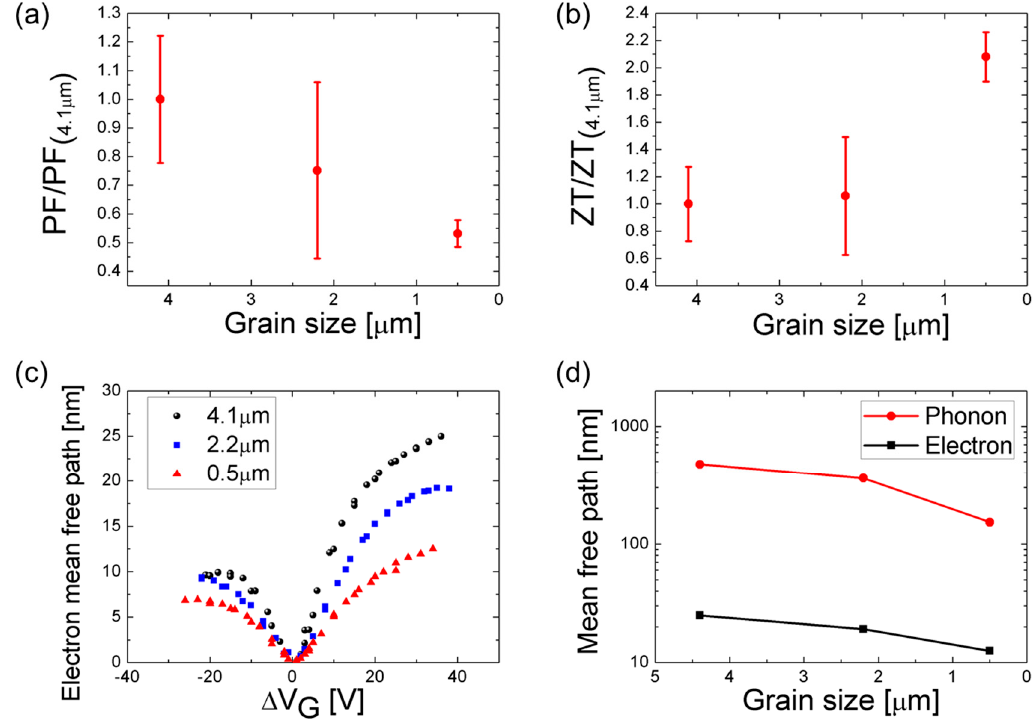
Figure 4. ( a ) Power factor dependence on the grain sizes of graphene. ( b ) Gradually increasing ZT with decreasing grain sizes. ( c ) Electron mean free path as a function of gate voltage for the graphene of grain sizes 4.1 µm, 2.2 µm, and 0.5 µm. ( d ) Phonon and electron mean-free-path of graphene of grain sizes 4.1 µm, 2.2 µm, and 0.5 µm.